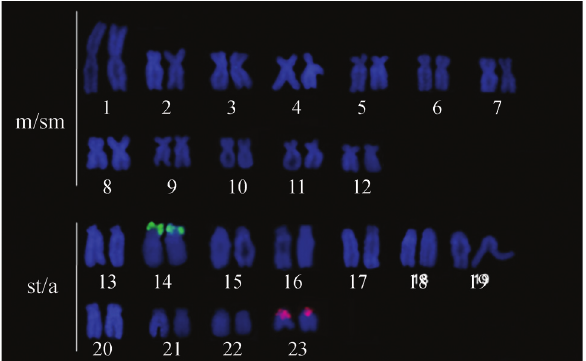
Figure3 -Distributionof18SrDNA(ingreen)and5SrDNA(inmagenta) in DAPI-stained karyotype of S. radians after